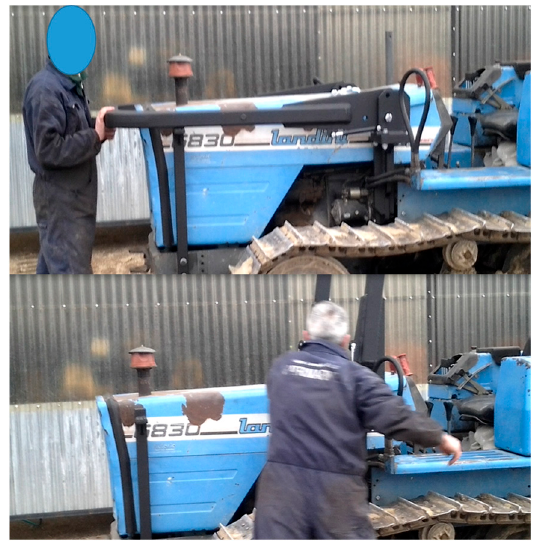
Figure 15. Practical tests of usability by farmers.